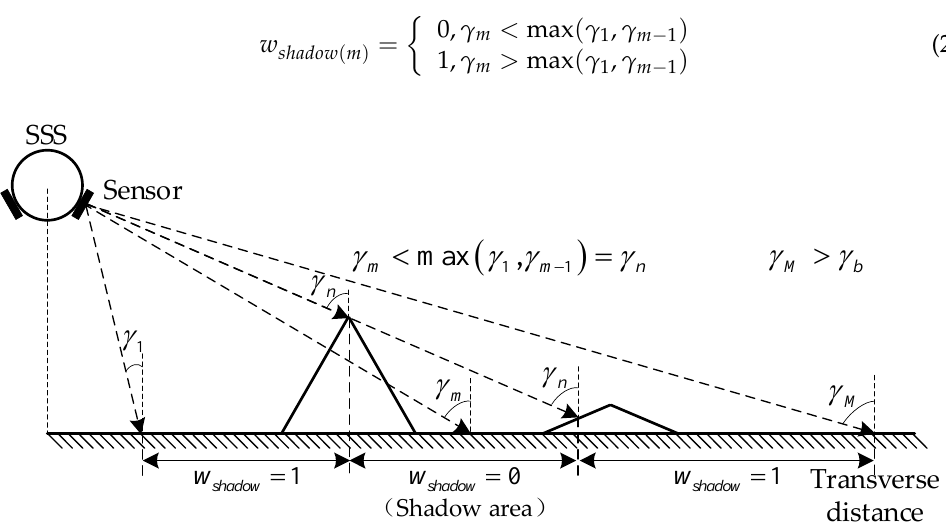
Figure 13. Geometric model for calculating shadow coefficient.